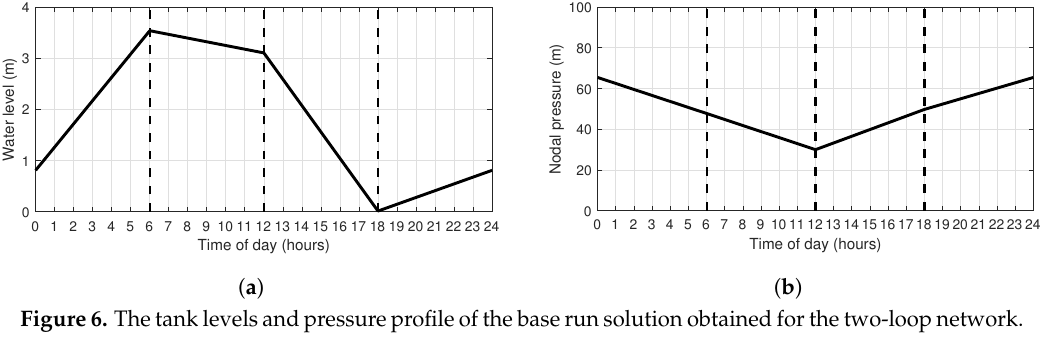
Figure 6. The tank levels and pressure profile of the base run solution obtained for the two-loop network. ( a ) The change of tank water level over time of a typical day of the best solution obtained for the two-loop network; ( b ) The change of pressure in the pressure critical node over time of a typical day of the best solution obtained for the two-loop